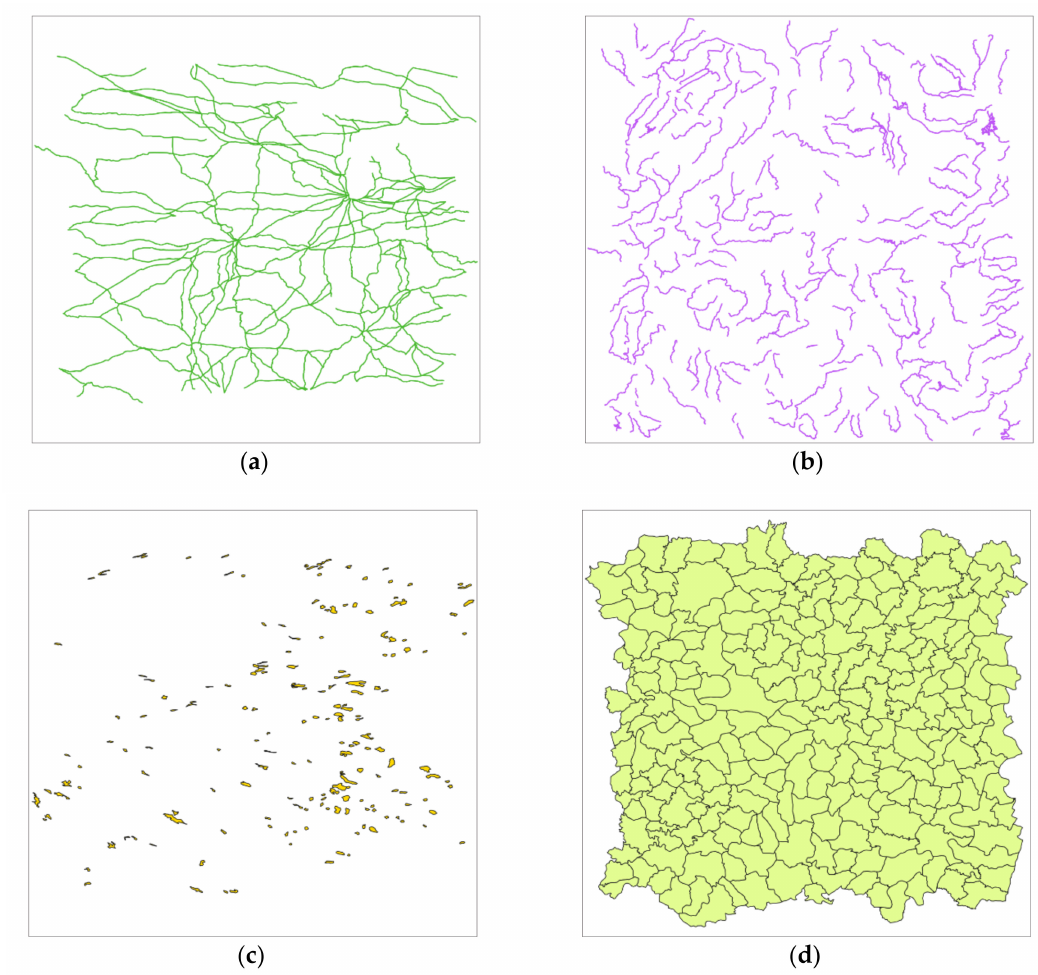
Figure 6. The host vector maps: ( a ) Railroad; ( b ) River; ( c ) Lake; ( d )